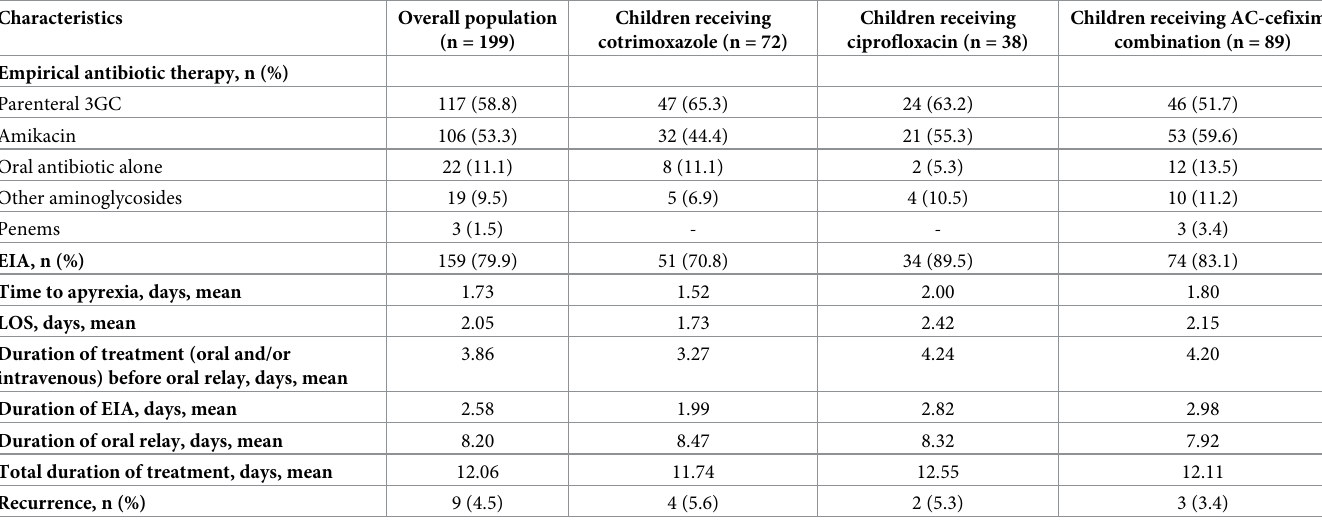
Table 2. Treatment and clinical evolution, according to oral antibiotic relay.